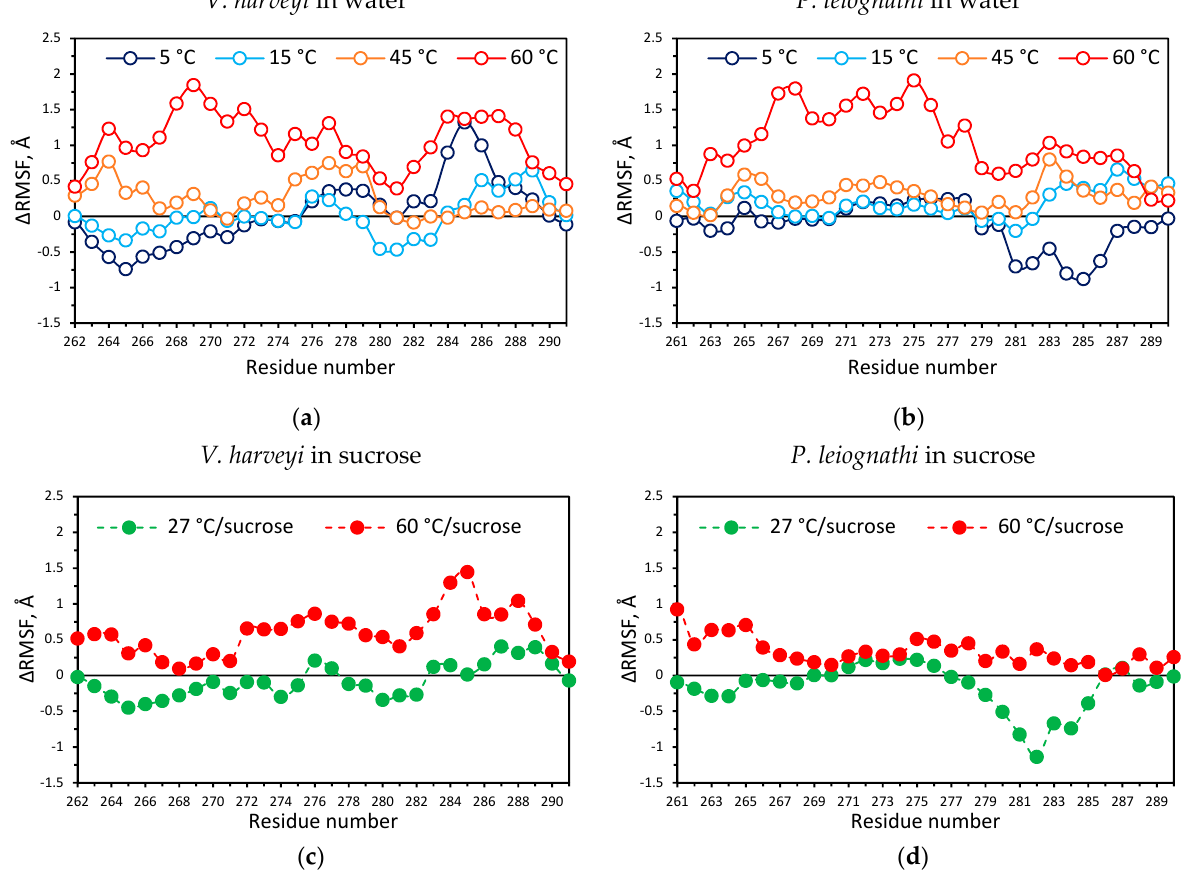
Figure 6. Δ RMSF of C α atoms of V. harveyi luciferase mobile loop (262–291 a. r.) in water ( a ) and water-sucrose ( c ) and P. leiognathi luciferase mobile loop (261–290 a. r.) in water ( b ) and water-sucrose ( d ) at different temperatures. The positive value of Δ RMSF corresponds to a more flexible segment as compared with the structure in water at 27 ° С , while the negative Δ RMSF corresponds to a more rigid segment. Correlation coefficients between the Δ RMSF profiles of V. harveyi and P. leiognathi mobile loops are presented in Table S2.